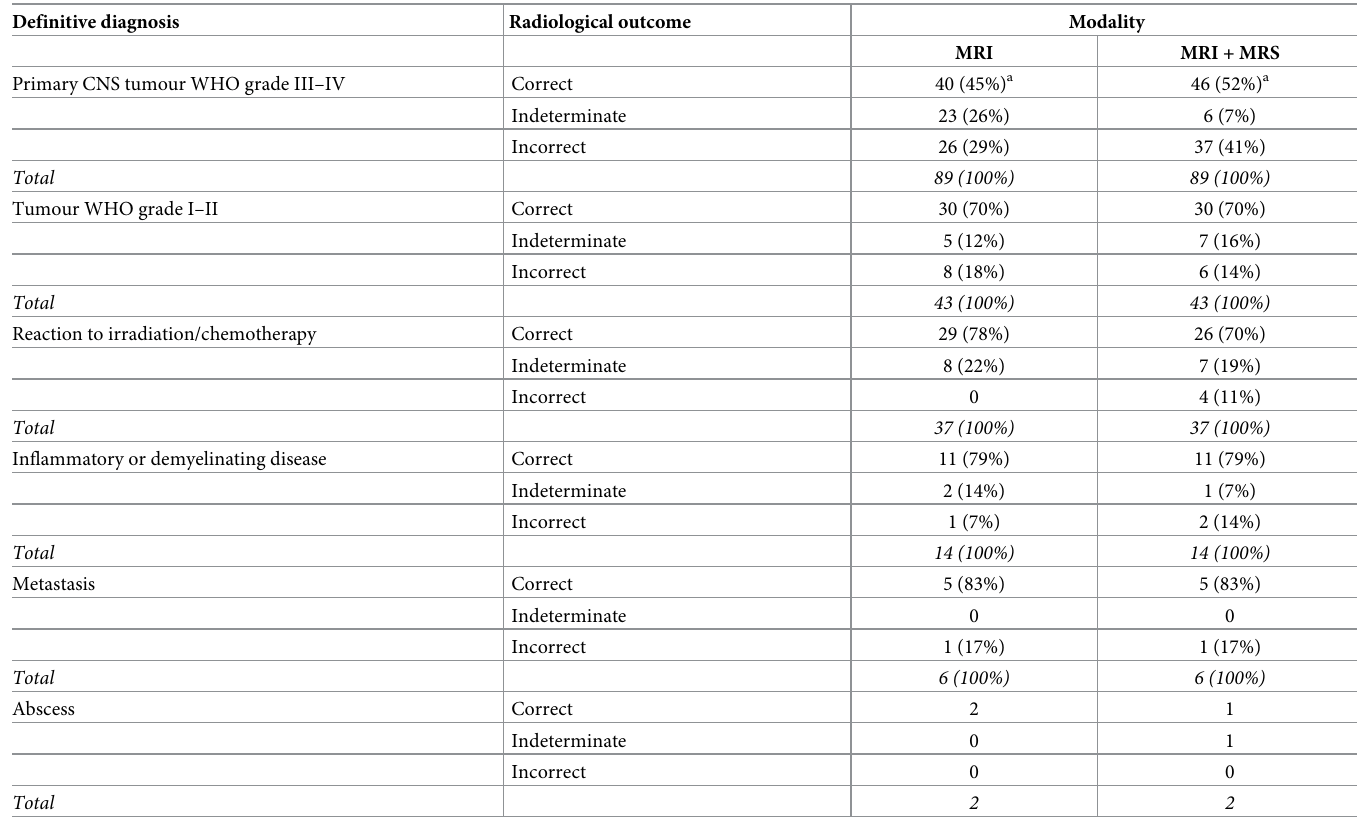
Table 5. Outcome of the radiological diagnostics in some subcategories.